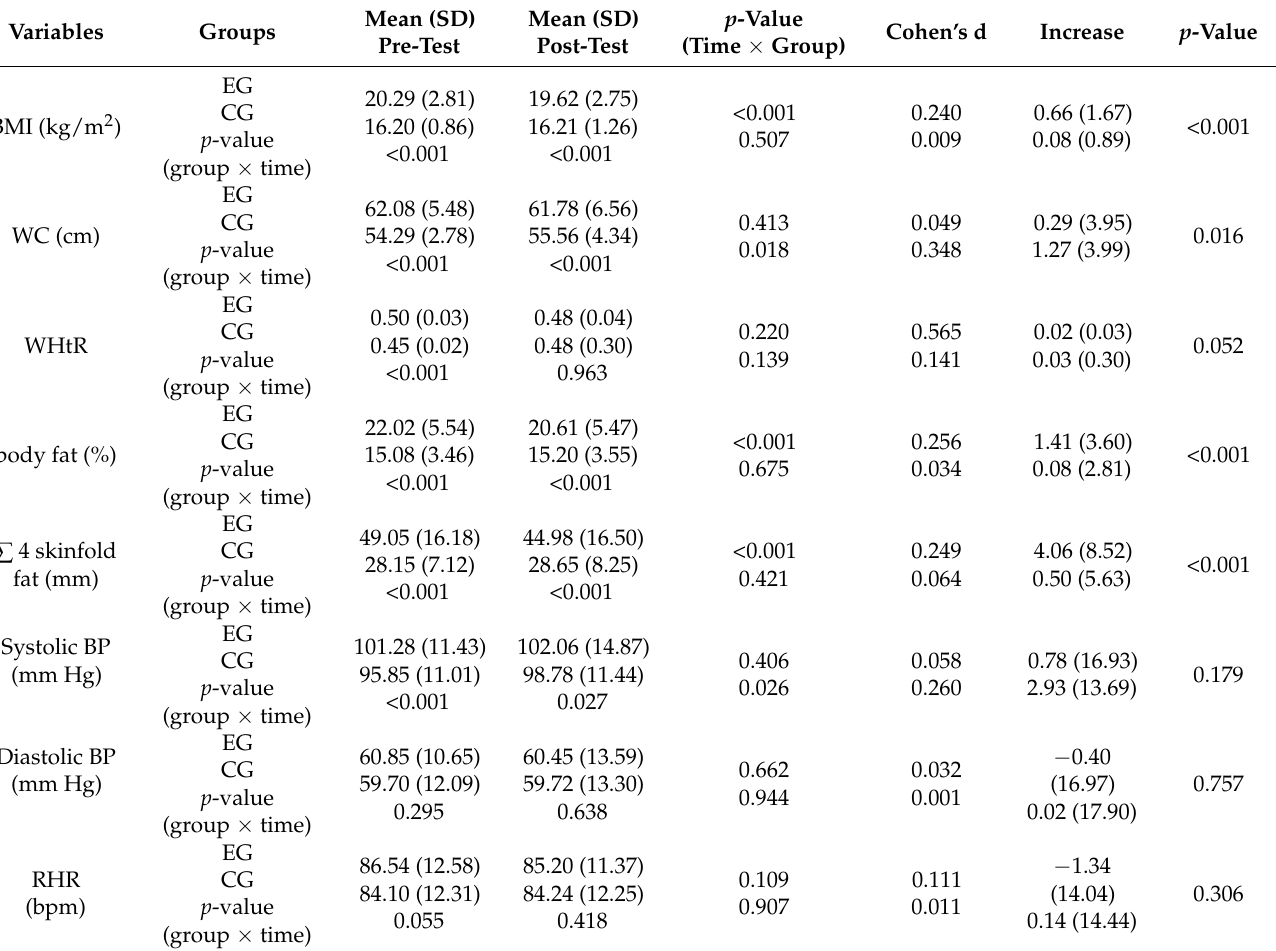
Table 1. Anthropometric data and CR before (pre-test) and after (post-test) intervention.